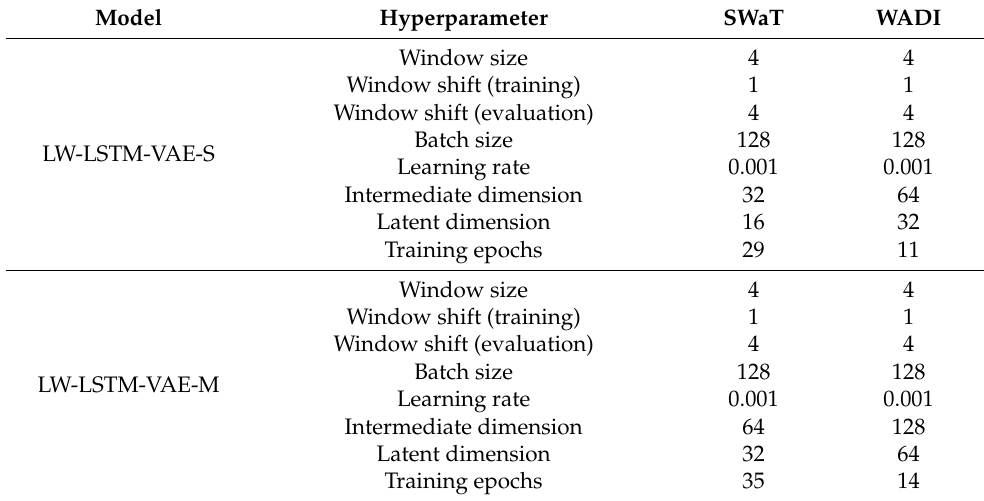
Table 4. The hyperparameters we used to obtain the reported results on the respective datasets.